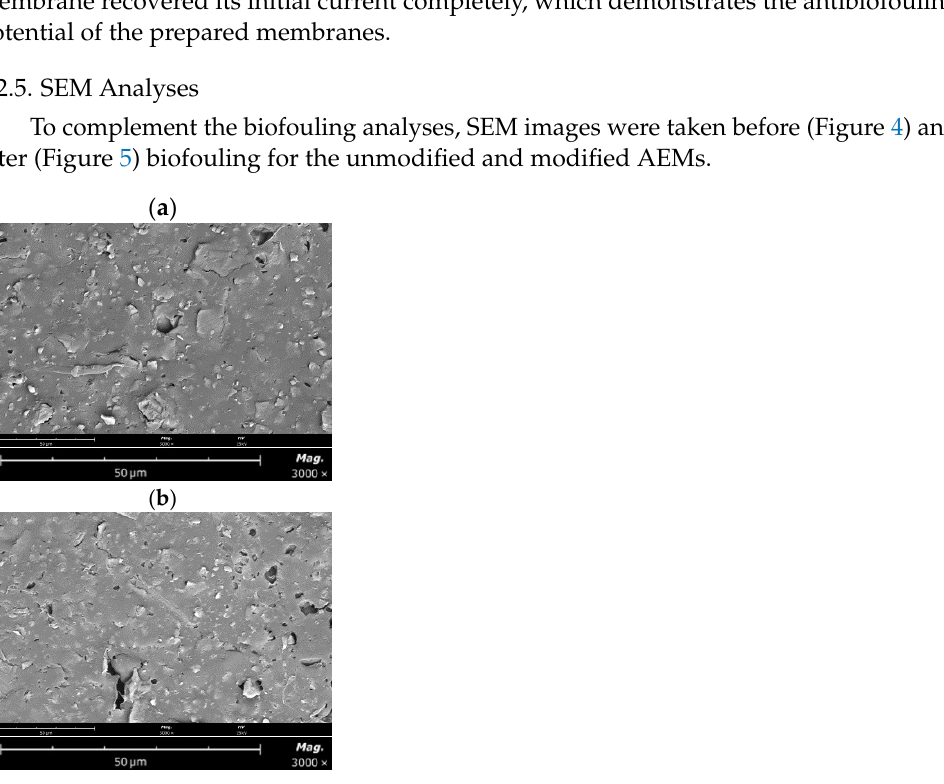
( b ) Figure 6. Images of the top surface of the membranes (taken in three different zones) obtained by SEM: ( a ) unmodified membrane and ( b ) modified fouled membrane after chemical cleaning.